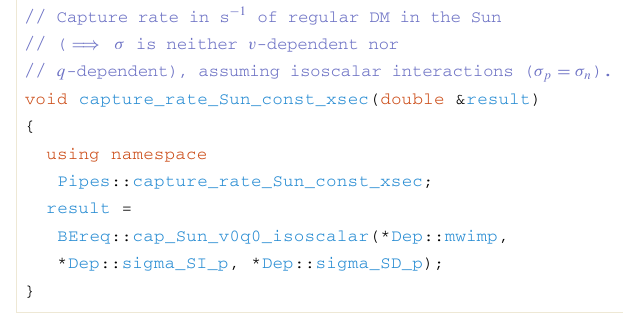
Fig. 2 The model hierarchy graph of the pre-defined models that ship with GAMBIT 1.0.0 . The graph forms a set of disconnected directed trees, potentially linked by friend translation pathways. Nodes are indi- vidual models . Black arrows indicate child -to- parent translation path- ways. The red arrows from MSSM9atQ to MSSM10batQ , and from MSSM19atQ to MSSM20atQ , indicate translations to friend mod-